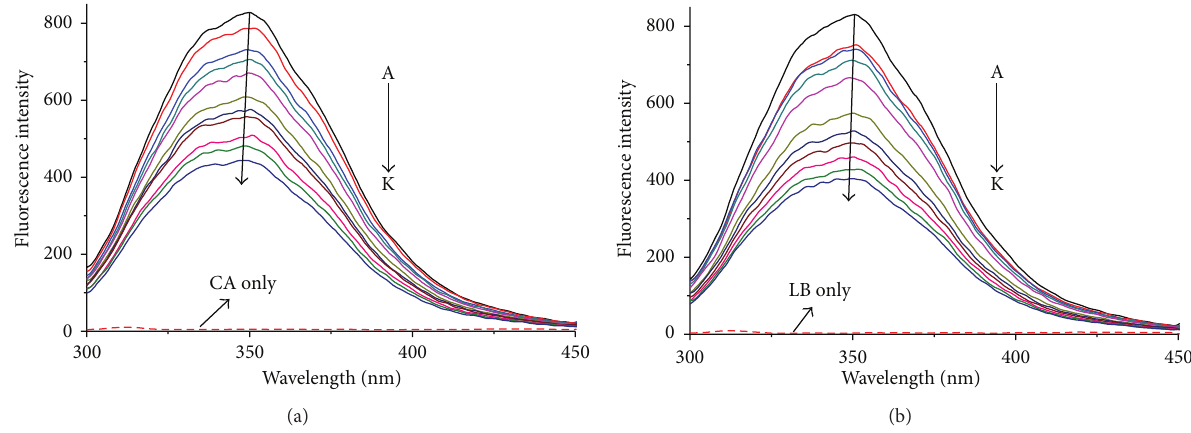
= 282 nm , pH = 7.40) . ex